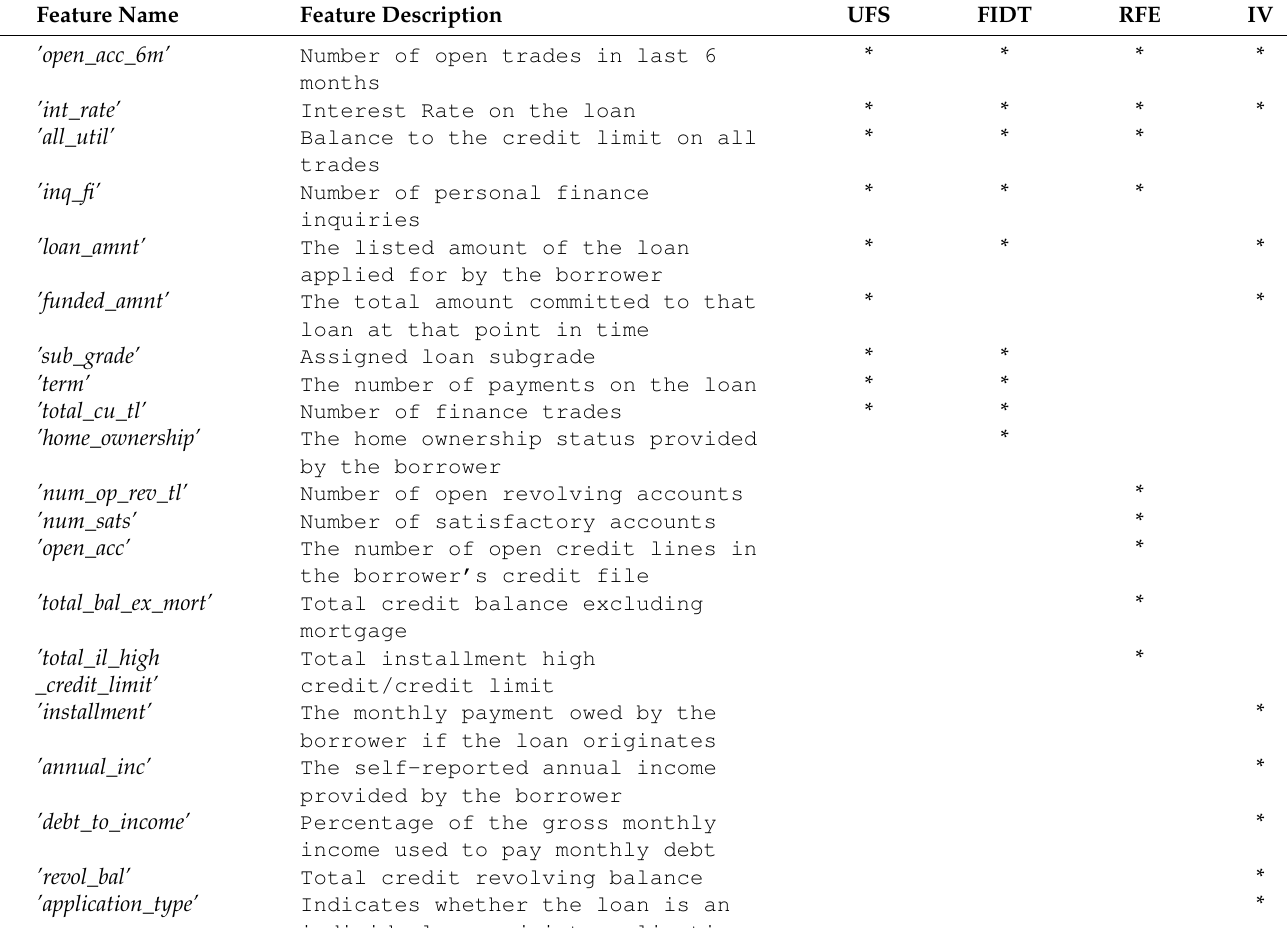
Table 3. List of selected